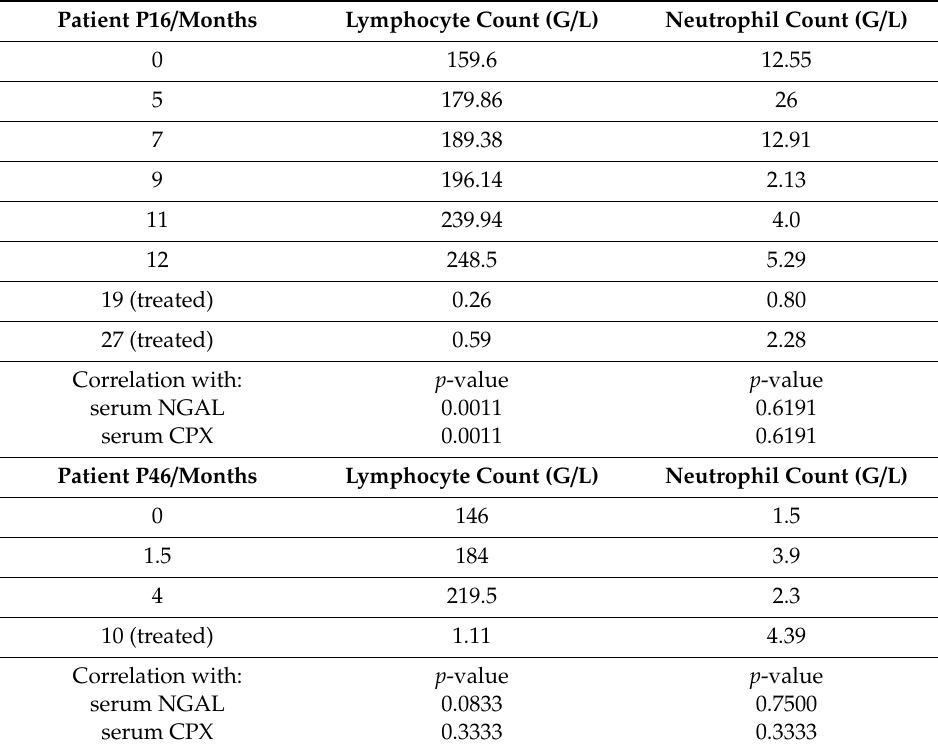
Table 2. Lymphocyte and neutrophil counts of patients P16 and